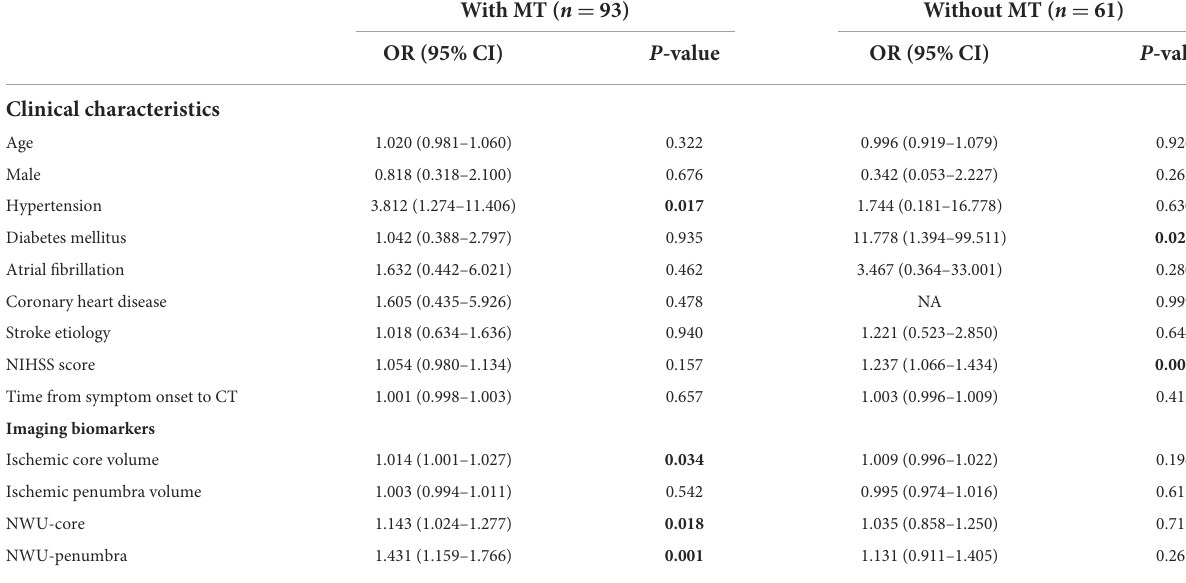
TABLE 2 Univariate logistic regression analysis for risk of sICH in patients stratified by reperfusion therapies. With MT ( n = 93) Without MT ( n = 61) OR (95% CI) P -value OR (95% CI) P -value